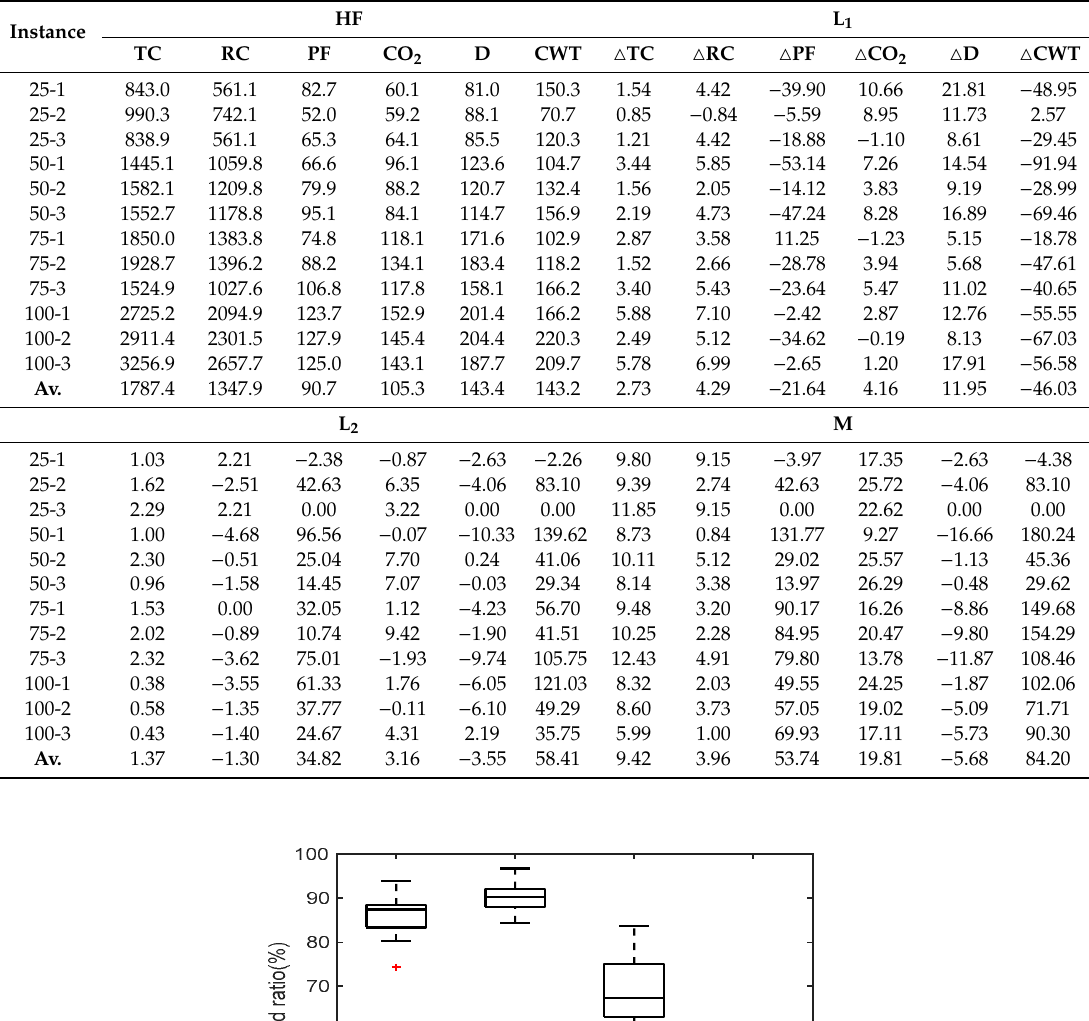
Table 7. Results of instances with di ff erent fleet.